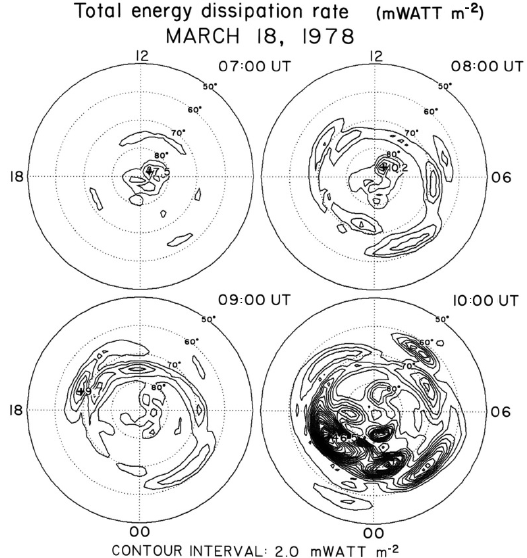
Figure 7. Joule heat production. The distribution of the Joule heat production in the ionosphere during a substorm, including a quiet period and the growth phase (prior to the expansion onset) (Aka- sofu,